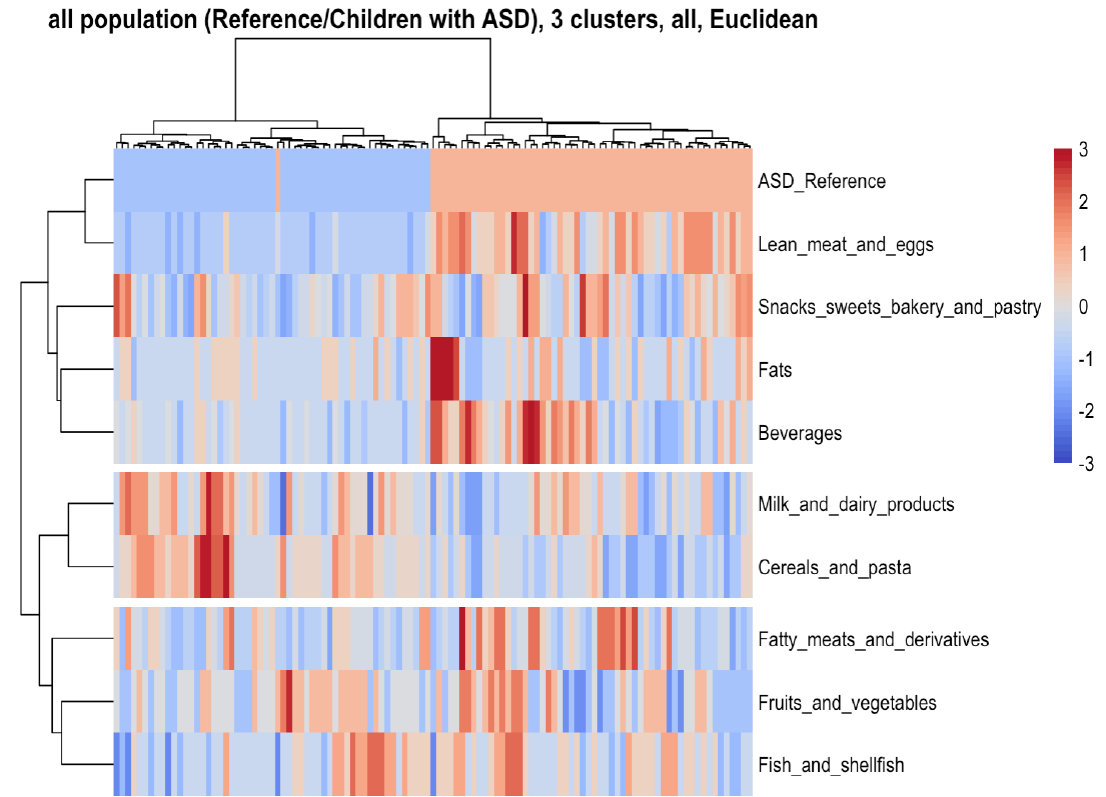
Figure 3. Clusters of subjects and dietary and lifestyle variables were identified via hierarchical clustering in control and ASD groups. The clusters are visually separated by longitudinal marks on vertical and horizontal faces (clusters of subjects and dietary variables, respectively). The vertical and horizontal dendrograms denote the relationship between the clusters, i.e., similar observations. The color bar refers to levels above (red) or below (blue) the mean intake of the dietary variable or means scores of food groups. Increased color intensities indicate larger differences around the mean. For the ASD control variable, ASD children are represented by the color blue and children of the control group by the color red.